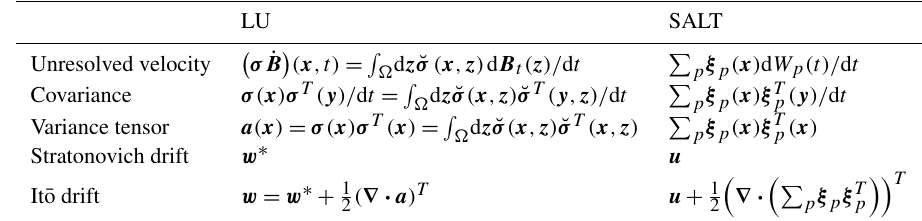
Table A1. Notation equivalences between LU and SALT